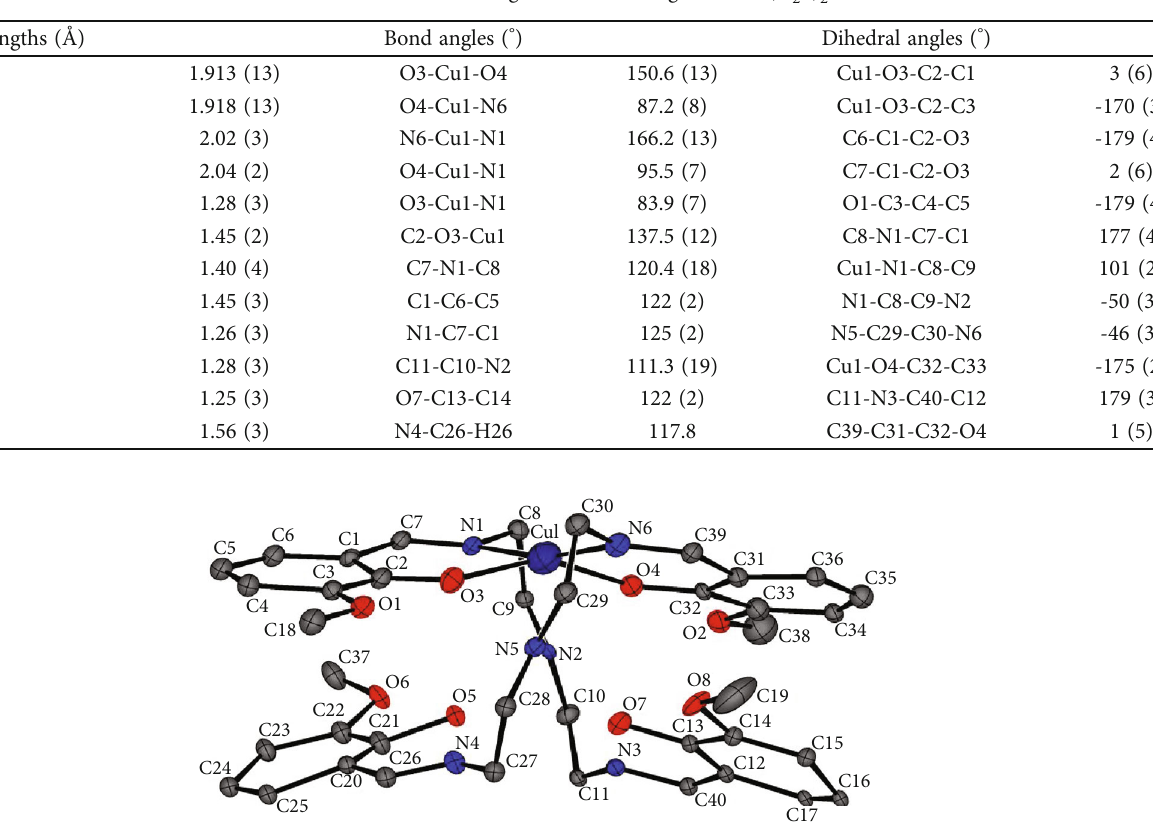
Table 2: Selected bond lengths and bond angles for Cu(H